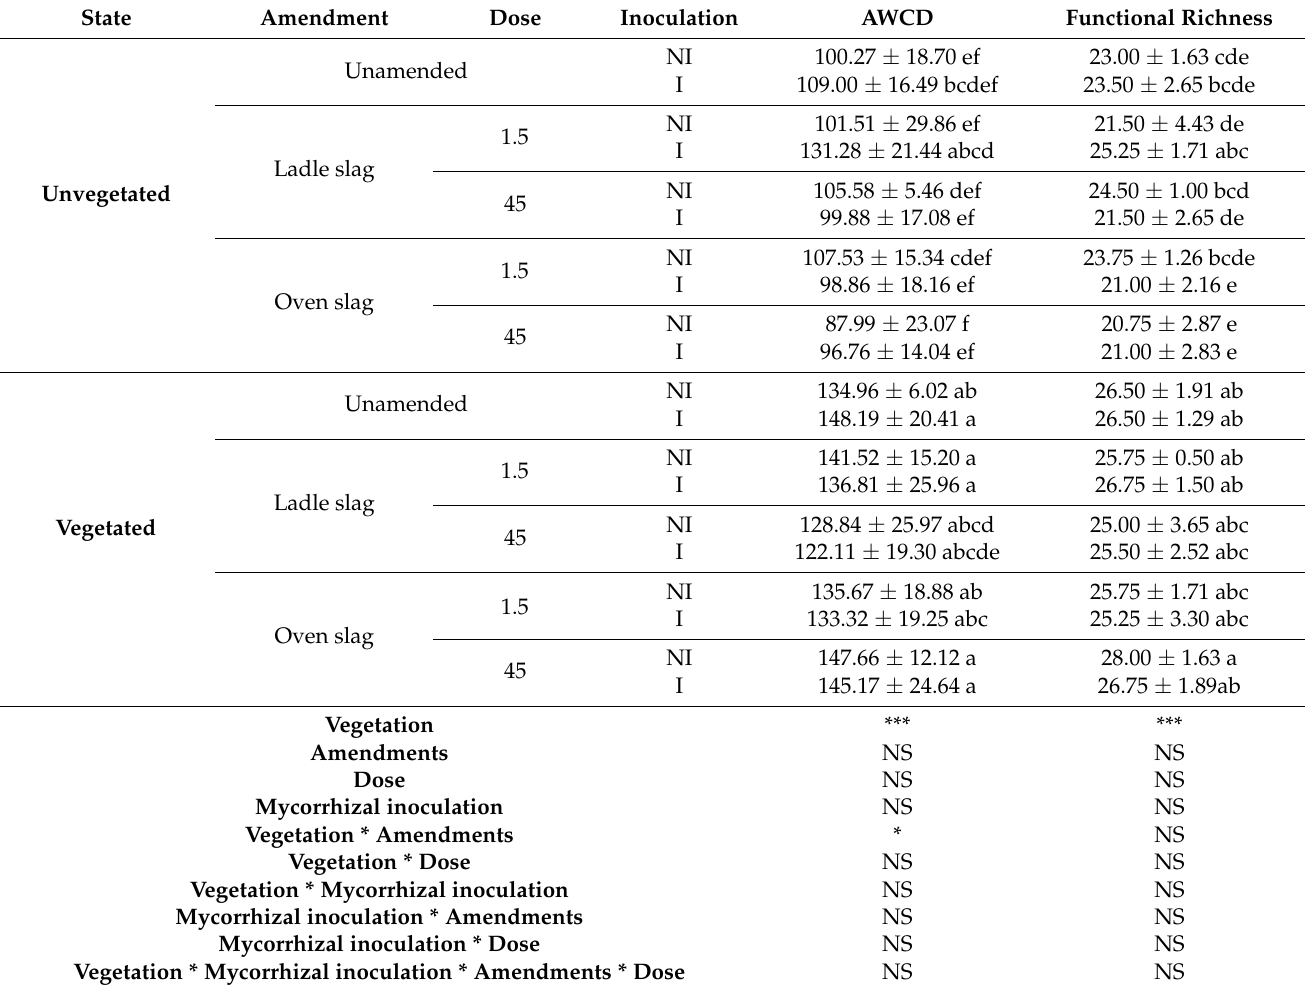
Table 4. Richness and diversity indexes of the 20 soil modalities. Data are mean ± SD ( n = 3) for each condition. Means followed by the same lowercase letter are not significantly different, by one-way ANOVA comparison and post-hoc Fisher test ( α =